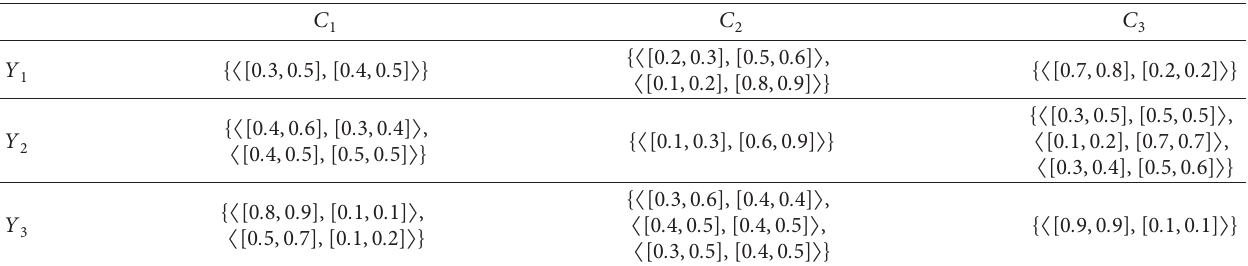
Table 3: IVPHFDM M ( 3 )